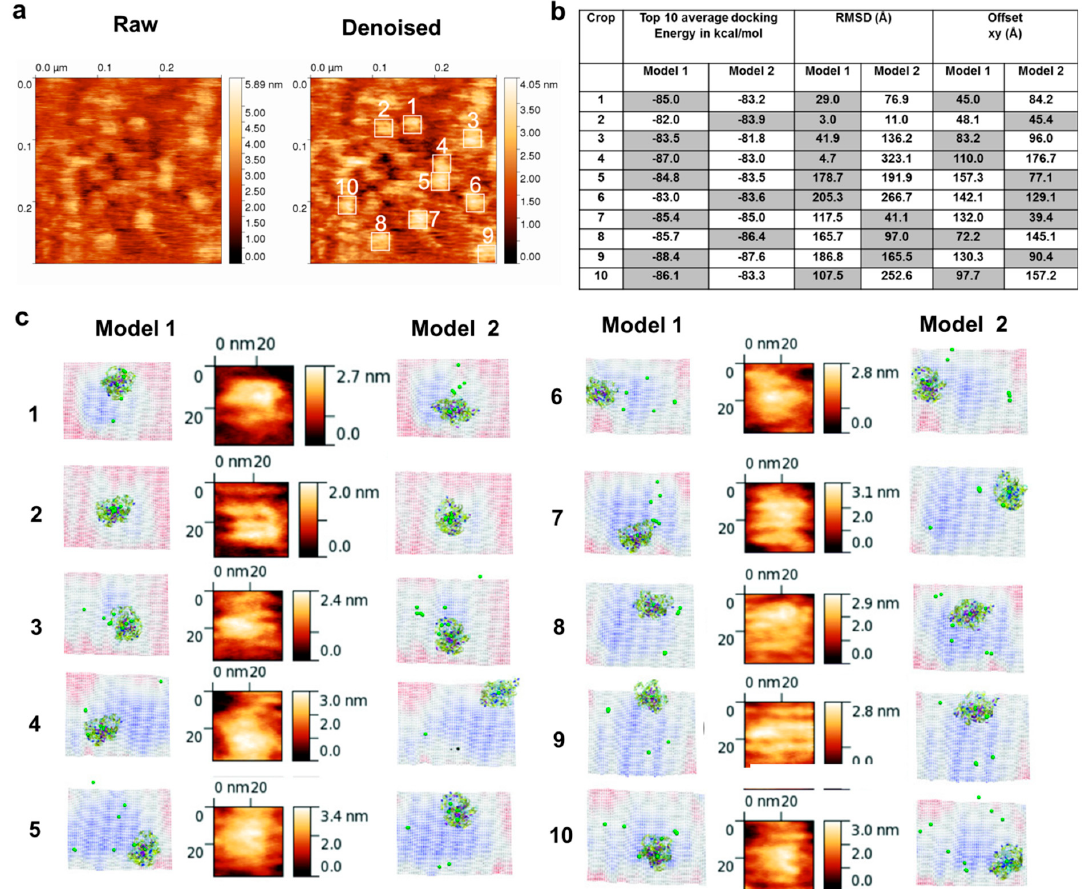
Figure 4. AFM based docking of FXIII complex models reveals model 1 as the best complex. ( a ) shows the raw and denoised AFM topographic images for the purified FXIII-A 2 B 2 complex. The height scales are depicted to their right. The denoised image also shows in white lined squares the crops on the topographic surface to which docking of the two best models (HADDOCK scores) of the FXIII-A 2 B 2 complex were performed on the DockAFM pipeline [30]. ( b ) is a table presenting the comparative scores obtained from the docking of the two FXIII-A 2 B 2 complex model structures on the ten AFM image crops depicted in ( a ). The xy (offset) represents the shift of the docked model structure (model 1 and model 2) from the center of the topographic surface. The most favorable structure is chosen as that having the smallest shift from the center. ( c ) shows side-by-side the best docking pose for the two FXIII-A 2 B 2 complex model structures on each of the ten crops side by side to a close-up topographic view of the crop itself. The topography of the docked pose is inverted, i.e., looking from below the surface. The color of the topography (blue to red) is the height in Z (red is low and blue is high). The structures of the two models are depicted in ribbon format.